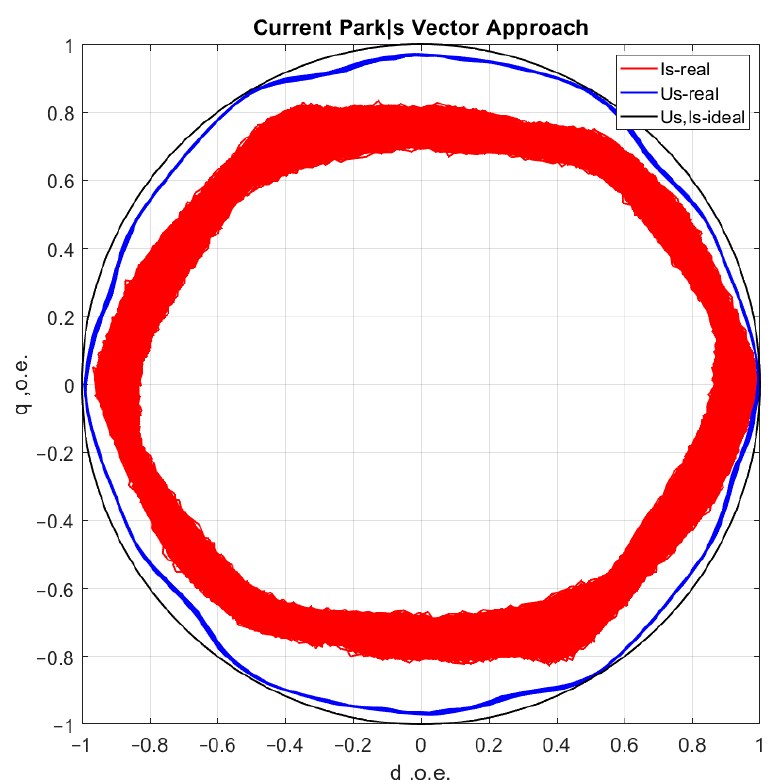
Figure 8. Motor operation with one shell in the inner ring of the bearing.